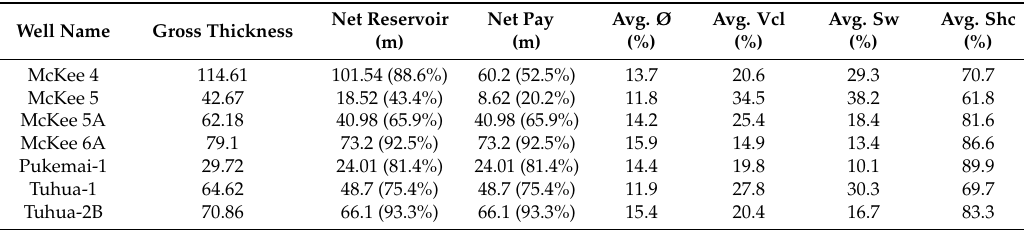
Table 2. The cut-off values obtained and averaged showing the reservoir and petrophysical parameters of the McKee Formation in the studied